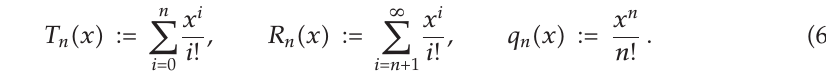
Figure 1: The sequence (cid:7) (cid:7) Φ (cid:7) n (cid:8) (cid:7) (cid:8)